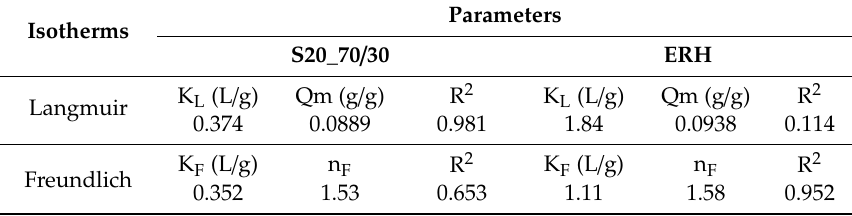
Figure 12. SEM image of ERH rice husk.